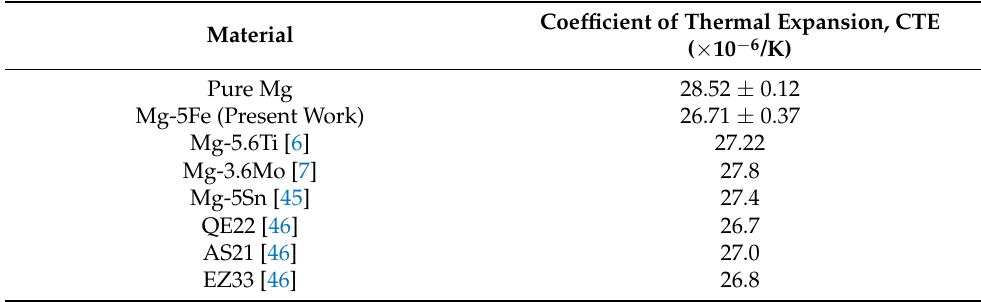
temperature resistant Mg alloys